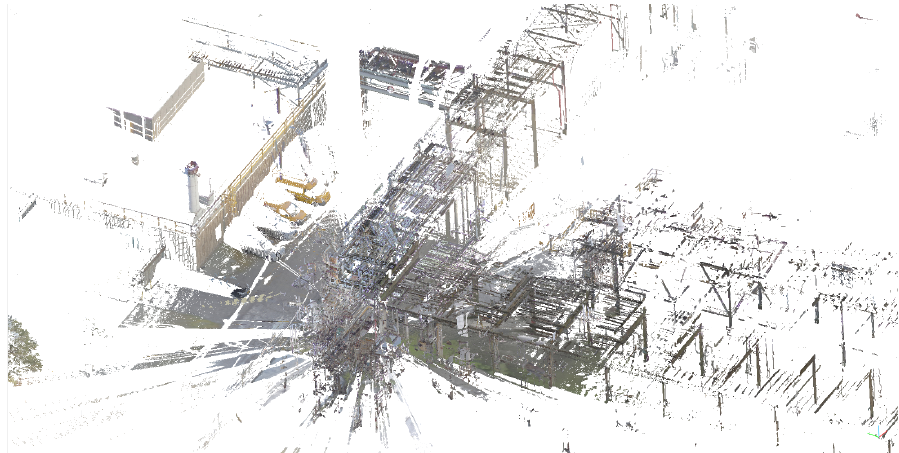
Figure 12. Part of the ground truth 3D point cloud of the Dow chemical site acquired using a Leica static terrestrial LiDAR scanning system.